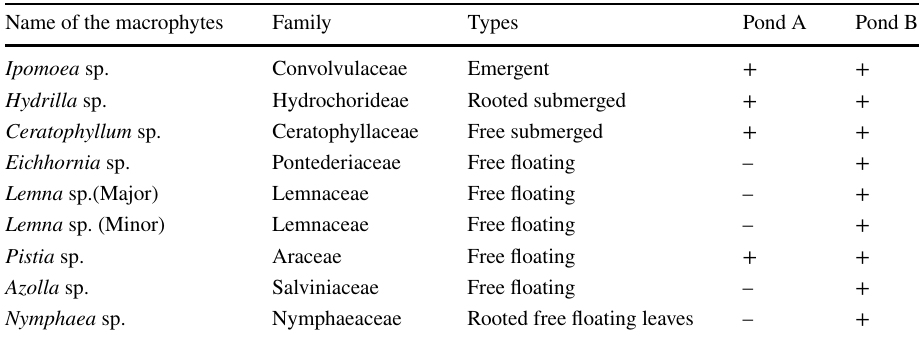
Table 2 Variations in aquatic macrophyte vegetations of two urban ponds (A and B) of Chandannagar recorded during the study period (Nov–Dec, 2017)